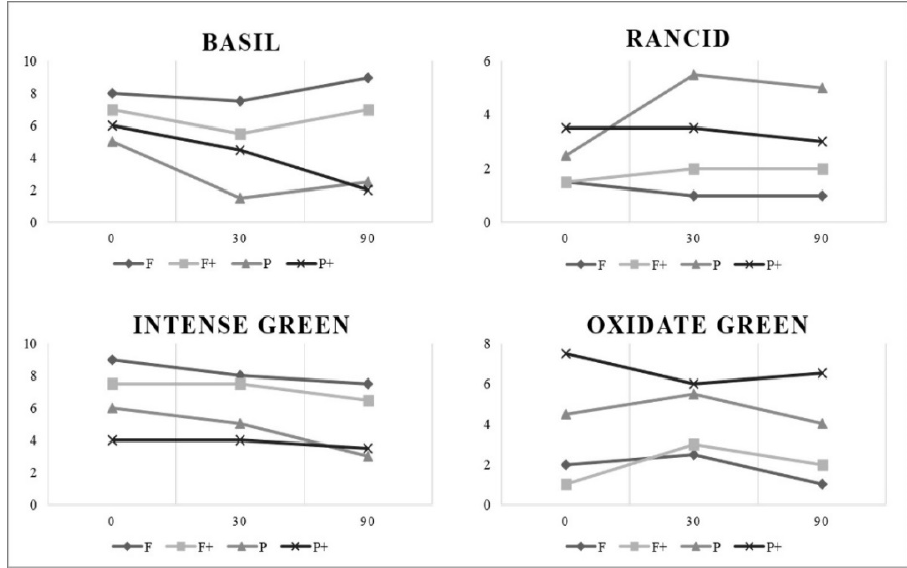
Figure 6. Sensorial evaluation of basil pesto samples during the storage period.